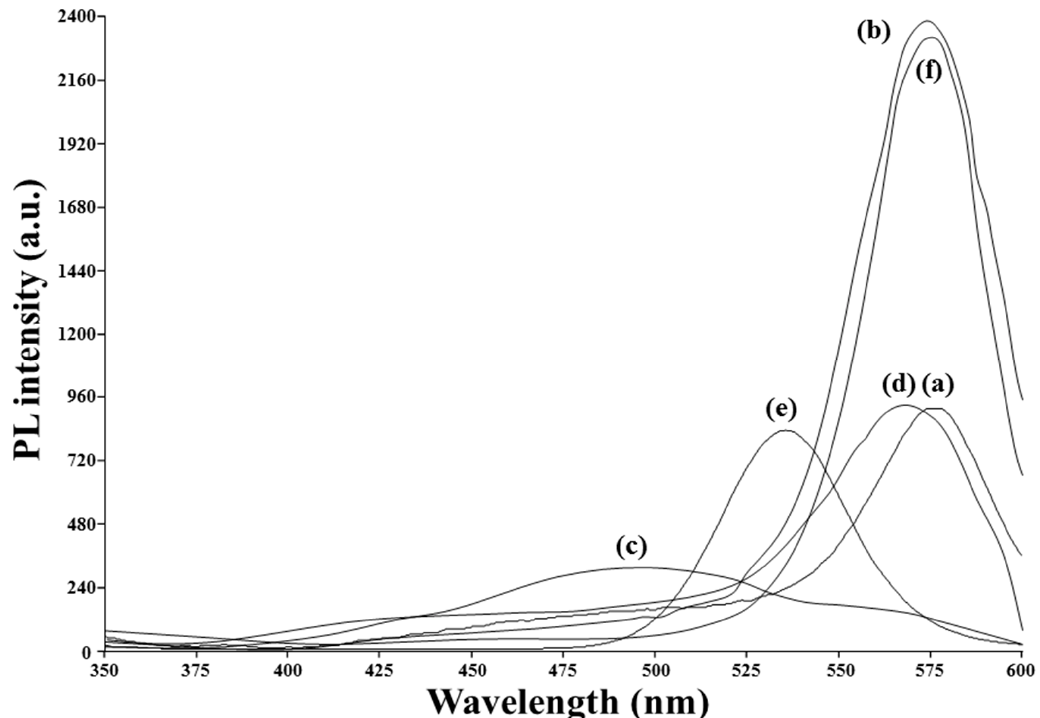
Figure 5. Fluorescence spectra of ( a ) MIP-plasma-PI, ( b ) Tc-stripped MIP-plasma-PI, ( c ) MIP-chem-PI, ( d ) Tc-stripped MIP-chem-PI, ( e ) CdTe QDs, and ( f ) NIP-plasma-PI. Excitation was set at 315 nm. Subfigures ( c ), ( d ), and ( e ) were used in ref. [21].